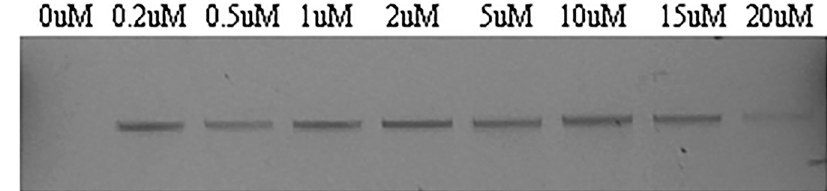
Fig 1. Phage DNA extraction from mitomycin C induced GMA1. Concentration of mitomycin C is indicated on the gel